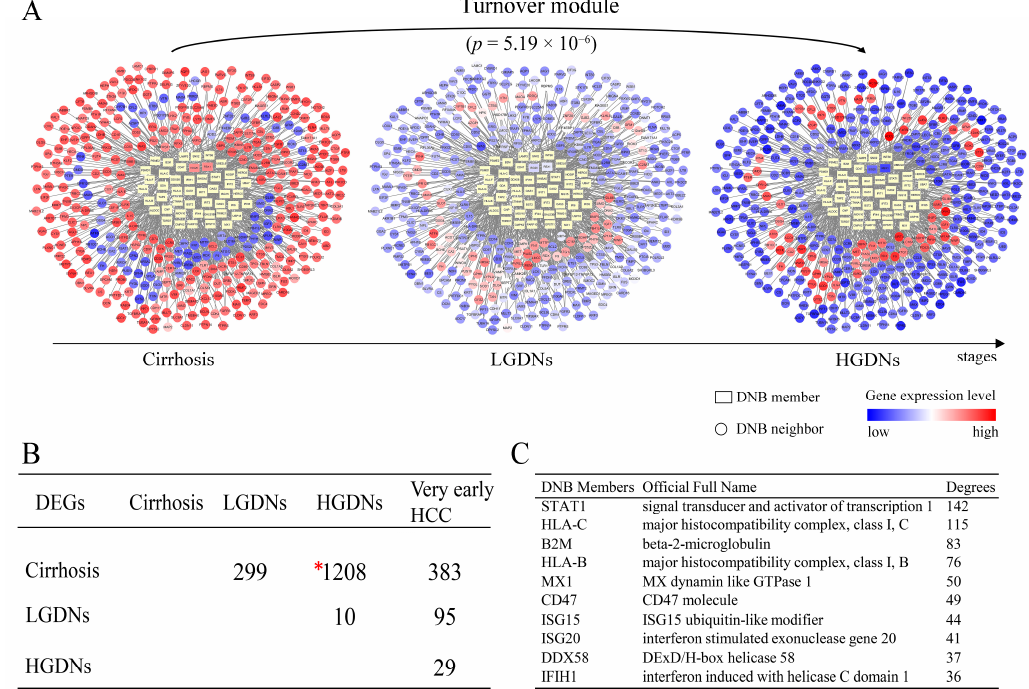
Figure 3. The DNB-associated network involving differentially expressed genes (DEGs) and dynamical changes of DEGs before and after the critical state. ( A ) These series of networks visually demonstrate the dynamic changes of DNB-associated network in terms of expressions before and after the critical state. There are 360 DEGs linked to DNB in the network, which significantly change from low (or high) at cirrhosis to high (or low) at HGDNs. Differentially expressed genes are significantly enriched in DNB-associated network with p = 5.19 × 10 − 6 by hypergeometric test. ( B ) The numbers of DEGs between any two stages during hepatocarcinogenesis. Genes with FDR adjusted p < 0.05 are considered to be differentially expressed by Student’s t -tests. One thousand two hundred eight DEGs between cirrhosis and HGDNs highlight the huge differences before and after the tipping point. ( C ) The top 10 DNB members with high degrees in the